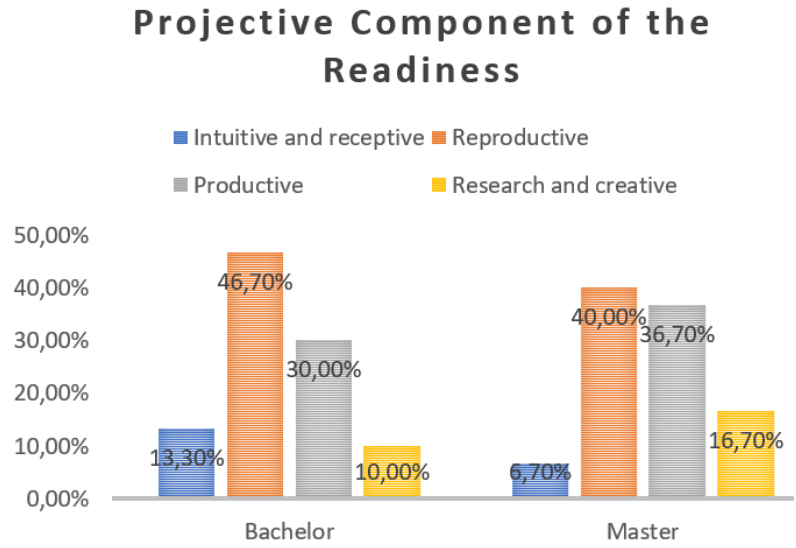
Figure 3: Diagram of the development of the projective component of the future primary education specialists’ readiness to use digital educational